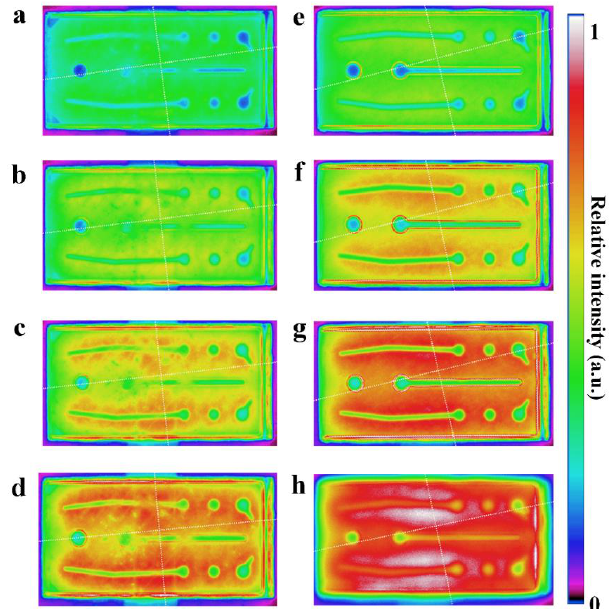
Figure 5. ( a – d ) Light emission intensity distribution images of FCLED without DBR at 100 mA, 150 mA, 200 mA and 250 mA. ( e – h ) Light emission intensity distribution images of FCLED with DBR at 100 mA, 150 mA, 200 mA and 250 mA.